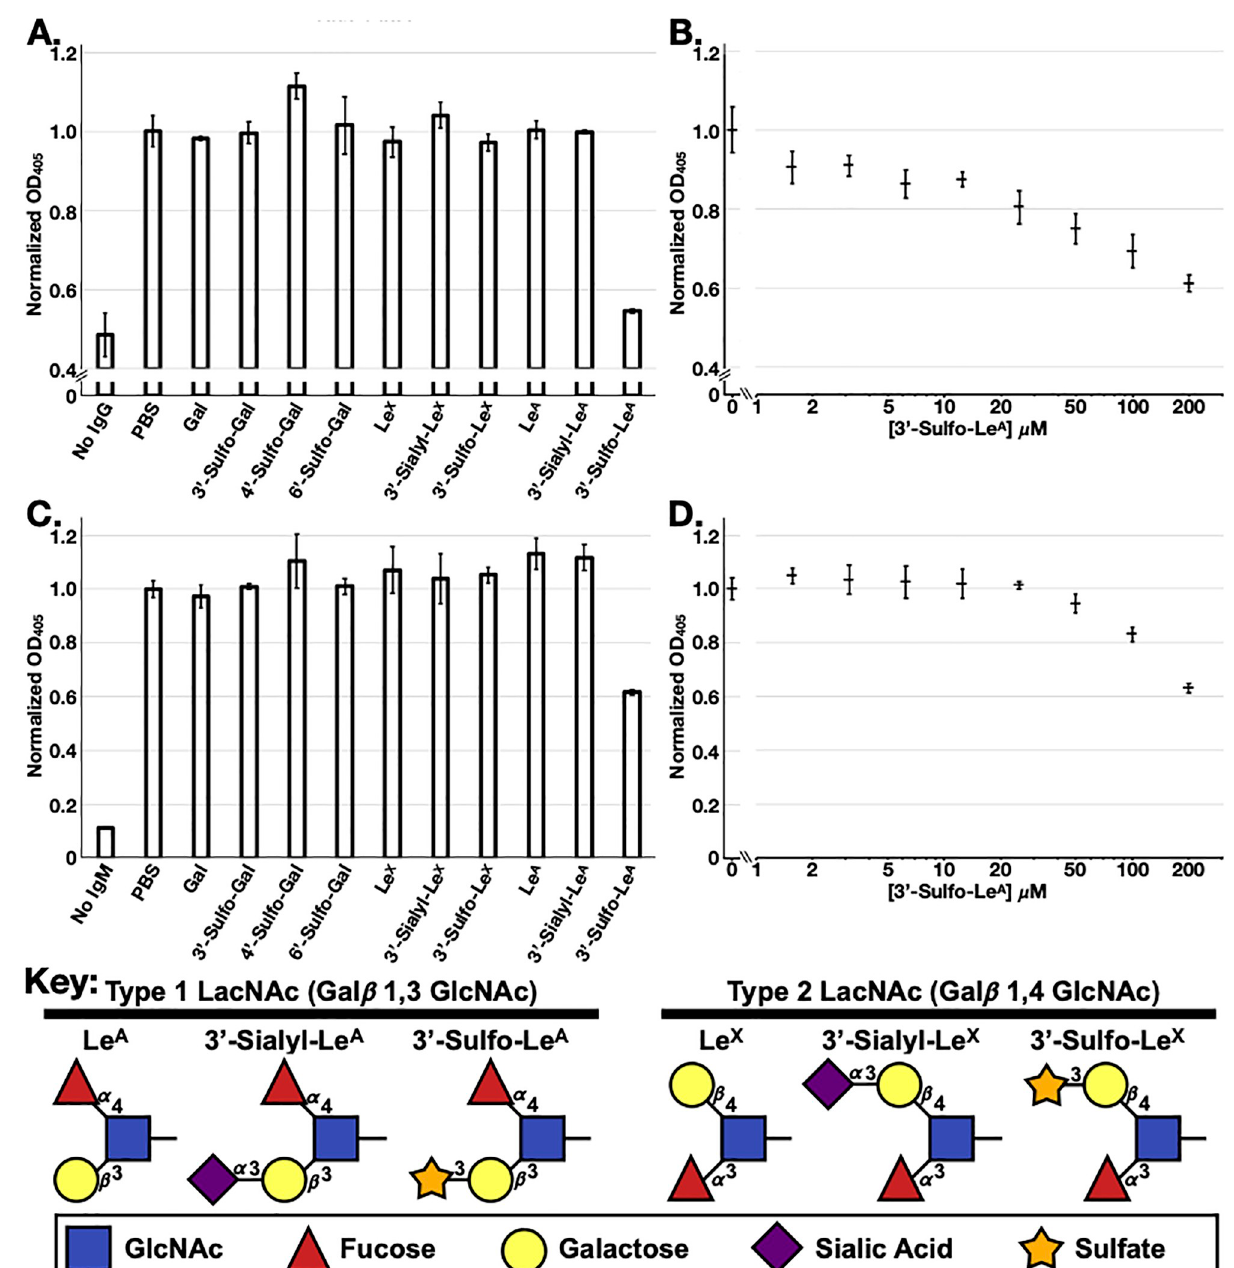
Fig 4. Das-1 IgG and IgM specifically recognize 3’-Sulfo-Le A . Direct ELISA using Das-1 IgG ( A ) or Das-1 IgM ( C ) in the absence or presence of several free glycans in solution at 200 μ M. Direct ELISA using Das-1 IgG ( B ) or Das-1 IgM ( D ) against a titration series of 3’-Sulfo-Le A . Data reported as average ± standard deviation of three technical replicates normalized to the reaction without glycans (PBS). Key : Schematic diagram of the relevant Lewis antigens is provided for